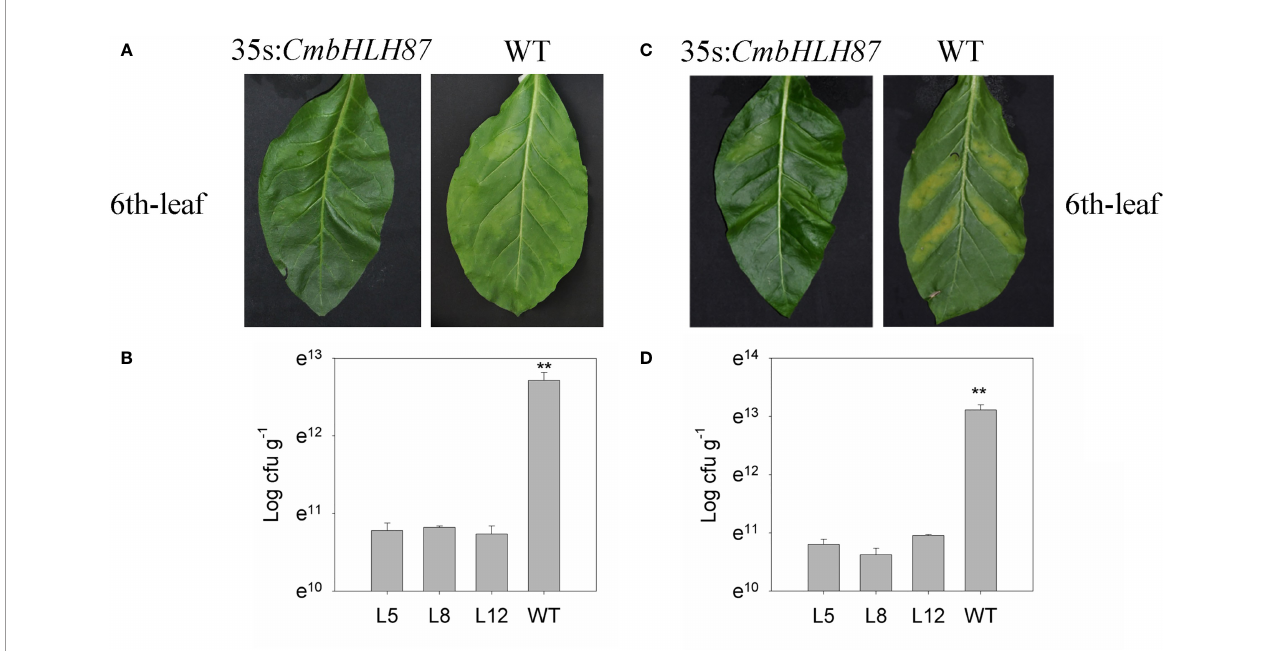
FIGURE 6 | The resistance of CmbHLH87 in tobacco plants to bacterial wilt and scab. (A) Pathogens symptoms of the 6th-upper leaf injection sites was injected with bacterial wilt bacteria with a needle-removed syringe; (B) concentration bacteria of the 6th-upper leaf injection sites was injected with bacterial wilt bacteria with a needle-removed syringe; (C) pathogens symptoms of the 6th-upper leaf injection sites was injected with scab bacteria with a needle-removed syringe; (D) concentration bacteria of the 6th-upper leaf injection sites was injected with scab bacteria. Three biological triplicates were averaged and bars indicate standard error of the mean. **denotes signi fi cant differences between wild-type (WT) and transgenic plants at p <